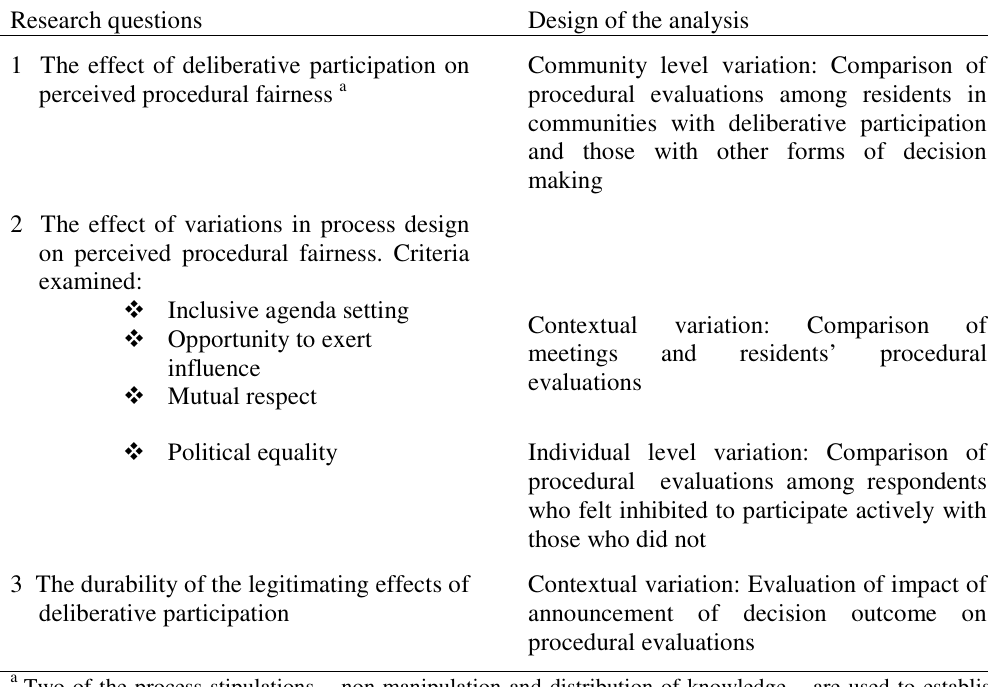
Table 1. Overview of empirical analyses of procedural stipulations. Research